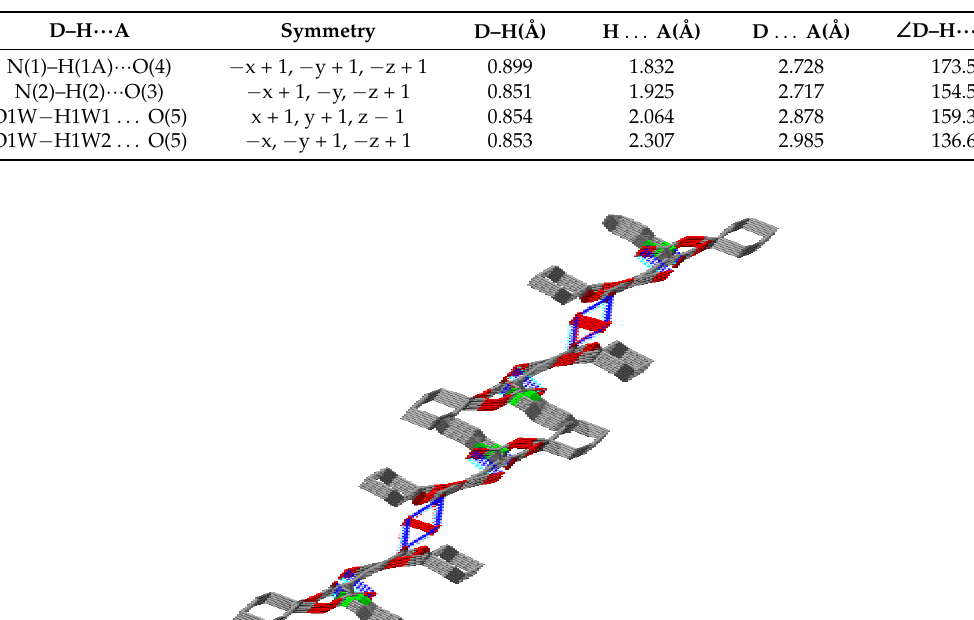
Table 2. Hydrogen bond distances and angles for the title compound.